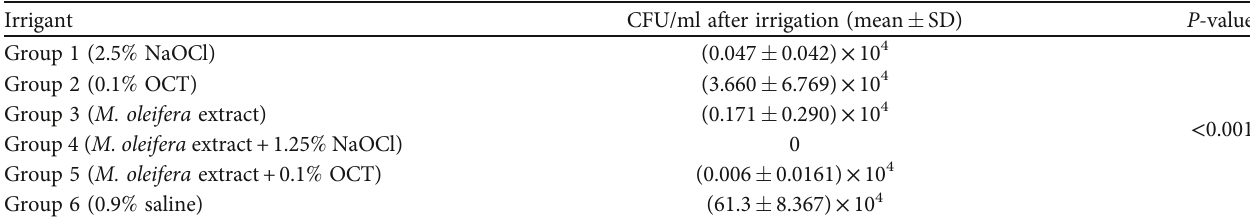
T ABLE 2: Enterococcus faecalis count (CFU-2/ml) of the tested groups after application of the